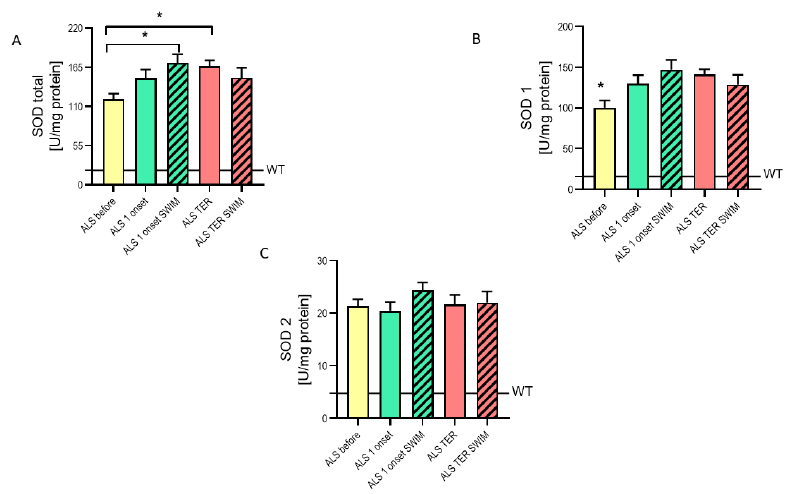
Figure 3. The total superoxide dismutase (SOD), cytosolic SOD and mitochondrial SOD activities in the spinal cord of ALS mice are significantly higher than in TW mice. ( A ) Total SOD activity, WT = 20.34 ± 0.91 U/mg protein, * p < 0.05 versus the rest of the ALS groups. ( B ) SOD 1 activity, WT = 15.56 ± 1.3 U/mg protein, * p < 0.05 versus ALS 1 onset and ALS TER groups. * p < 0.05 with ALS 1 onset and ALS TER groups. For ( A , B ) LSD post hoc tests were used after one-way ANOVA. ( C ) SOD 2 activity, WT = 4.78 ± 1.05 U/mg protein. For ( A – C ): WT n = 6/8, ALS before n = 8/8, ALS 1 onset n = 7/8, ALS 1 onset SWIM n = 6/7, ALS TER n = 10/10, ALS TER SWIM n = 10/10. The GPx activity in pre-symptomatic ALS mice spinal cords was significantly lower than in WT mice, and it was decreased by 2-fold in comparison to the healthy WT mice ( p < 0.05) (Figure 4A). Given the over 6-fold higher SOD1 activity, these results show that GPx activity might not be required for maintaining oxidative balance at the pre-sympto- matic stage of ALS. However, with disease progression, at the first onset of the disease, we found 2.6-fold higher GPx activity, 1786.0 ± 78.42 in the ALS before group, and 4703.0 ± 268.8 nmol/min/mg protein in the ALS 1 onset group ( p < 0.05). At the terminal stage of the disease, the GPx activity dropped again to the initial level (1943.0 ± 69.6 nmol/min/mg protein). However, the swim training brings a significant effect on GPx activity. At the first onset of diseases, the trained group already showed elevated GPx activity compared to the ALS 1 onset group. However, the most remarkable change was observed at the terminal stage of ALS. In the ALS TER SWIM group, 115% higher GPx activity was found than in the ALS TER group ( p < 0.005) (Figure 4A). Next, we investigated if the GPx activity was dependent on the reduced glutathione (GSH) availability. Despite low GPx activity at the pre-symptomatic stage of the disease, the GSH concentration in the spinal cord in the ALS before group was only slightly lower than in the WT before group, and it was respectively 8.62 ± 0.2 in the ALS before group and 9.4 ± 0.5 μM in the WT before group. Nevertheless, with the disease progression, the GSH concentration gradually de- clined to the 7.8 ± 0.4 μM at the terminal stage in the ALS TER group ( p < 0.05). The swim training seems to stop the lowering of the concentration GSH. However, the observed trend was not statistically significant (Figure 4B). The activity of CAT in the WT before group was lower than in all ALS groups. The CAT activity was not changed at the first onset of the disease. However, at the terminal stage of the disease, the CAT activity significantly rose ( p < 0.05) (Figure 4C). The swim training seems to increase the activity of CAT activity at the first onset of the ALS disease, yet at the terminal stage, it had the opposite effect. The CAT activity in the ALS TER SWIM group was lower than in the ALS TER group. It is important to note that elevated CAT activity in the ALS TER group was associated with lower GPx activity and lower GSH